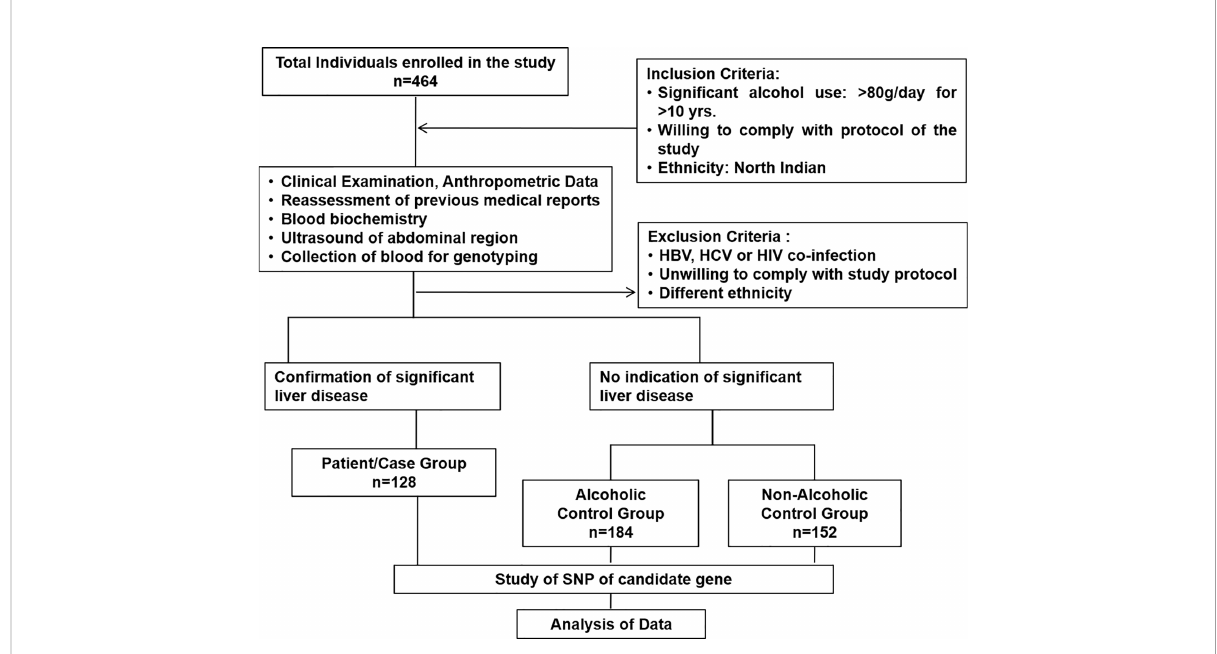
FIGURE 1 Consort diagram of study cohort with inclusion and exclusion criteria.